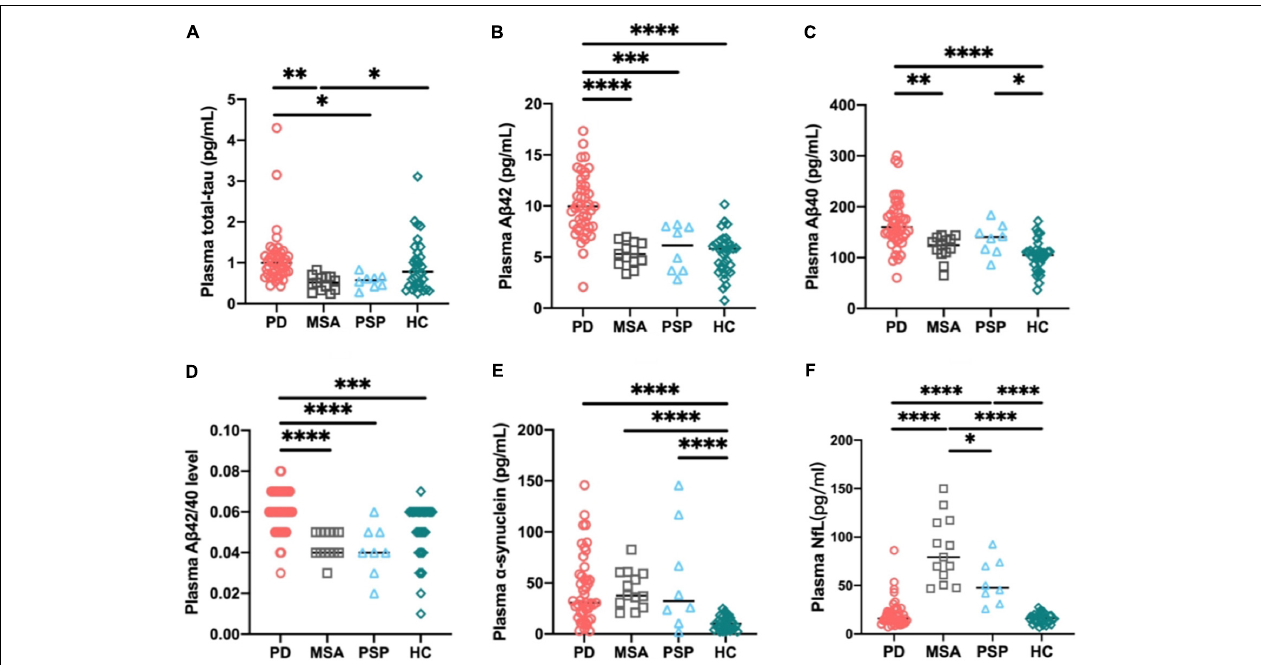
FIGURE 1 | Individual plasma biomarker levels of normal controls and in different diagnostic groups. The plasma total tau (A) , A β 42 (B) , and A β 42/40 (D) levels were significantly increased in patients with PD compared with those in APD. The plasma A β 40 (C) , A β 42/40 (D) , and α -synuclein (E) levels were significantly higher in PD group compared with healthy controls. The plasma NfL (F) level was significantly increased in patients with MSA and PSP compared with PD and controls. p -values are from multiple linear regression models adjusting for age, sex, and disease duration. PD, Parkinson’s disease; MSA, multiple system atrophy; PSP, progressive supranuclear palsy; HC, healthy controls; NfL, neurofilament light chain; A β 42, β -amyloid 42; A β 40, β -amyloid 40; A β 42/40, β -amyloid 42/40; ∗∗∗∗ p < 0.0001, ∗∗∗ p < 0.001, ∗∗ p < 0.01, ∗ p < 0.05.